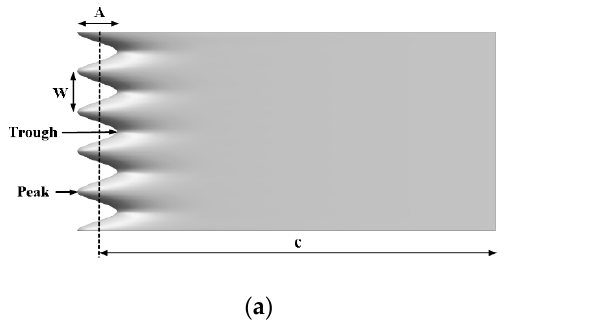
Figure 1. Design of wavy leading edges: ( a ) structure of the wavy-leading-edge airfoil; ( b ) spanwise- section generation method.